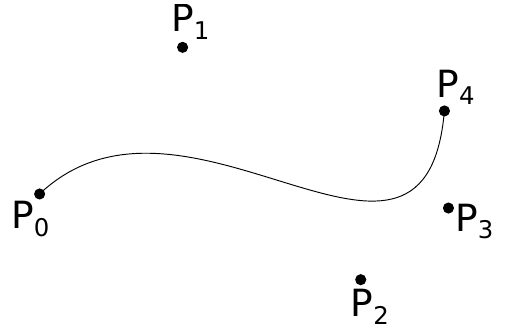
Figure 3. Bezier curve through control points P 0 ,P 1 , · · · ,P 4